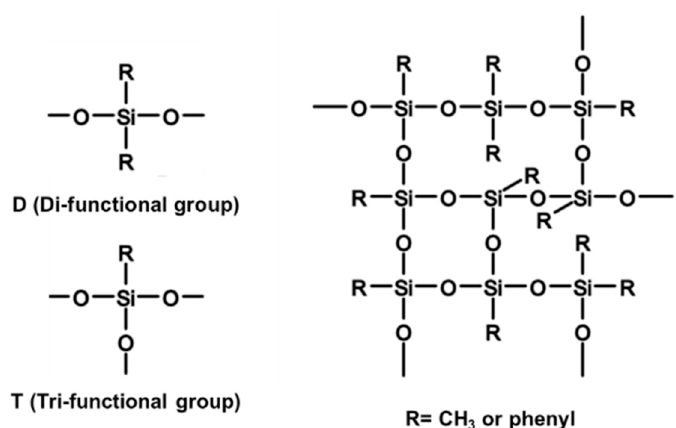
Figure 2. Basic structure of the pure silicone resins.